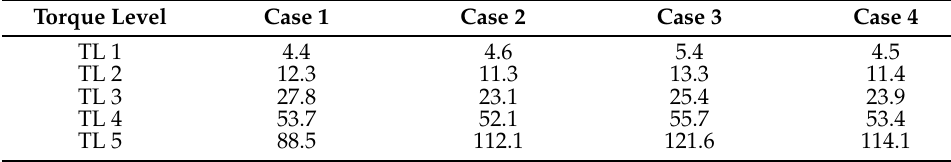
Table 9. The energy consumption per walking step (milliwatts).